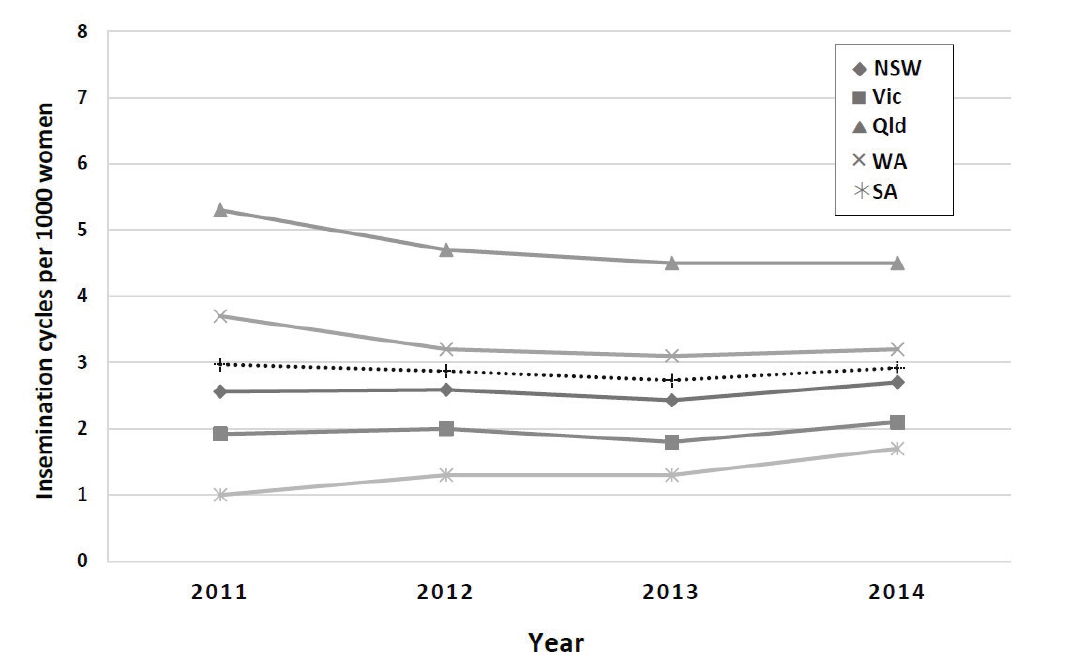
[NSW – New South Wales, Vic – Victoria, Qld – Queensland, WA – Western Australia, SA – South Australia. Overall national incidence rate for Australia as black dashed line] Figure 4. Age-stratified incidence rate of intrauterine insemination (IUI) cycles in women aged 35 to 44 years in Australia (cycles per 1000 women per year), 2011 to 2014 inclusive